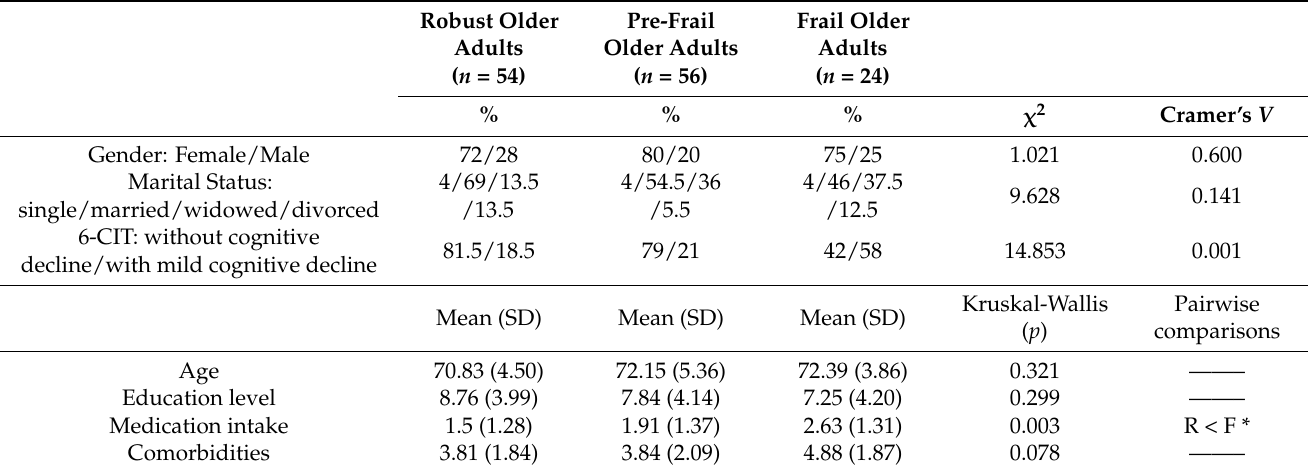
Table 1. Demographic, clinical, and neuropsychological characteristics of the sample. Robust